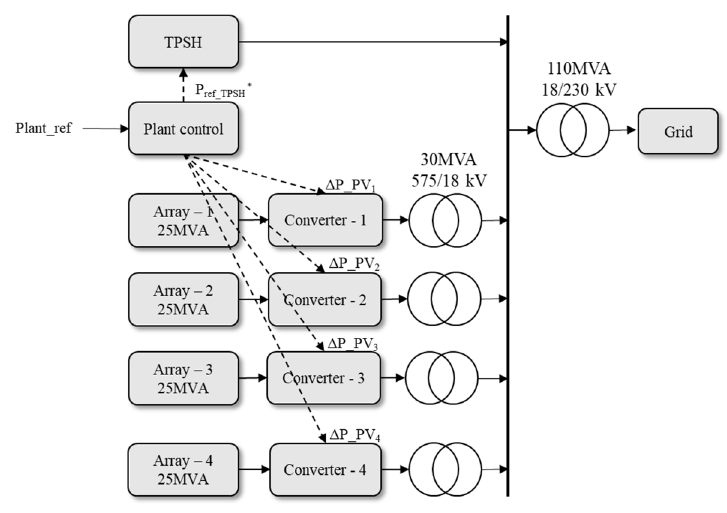
Figure 2. Schematic showing a hybrid PV–TPSH plant.